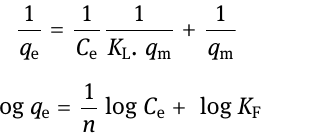
maximum amount of drugs adsorbed ( mg g − 1 ) , C equilibrium concentration of acidic drugs ( mg L − 1 ) , and q